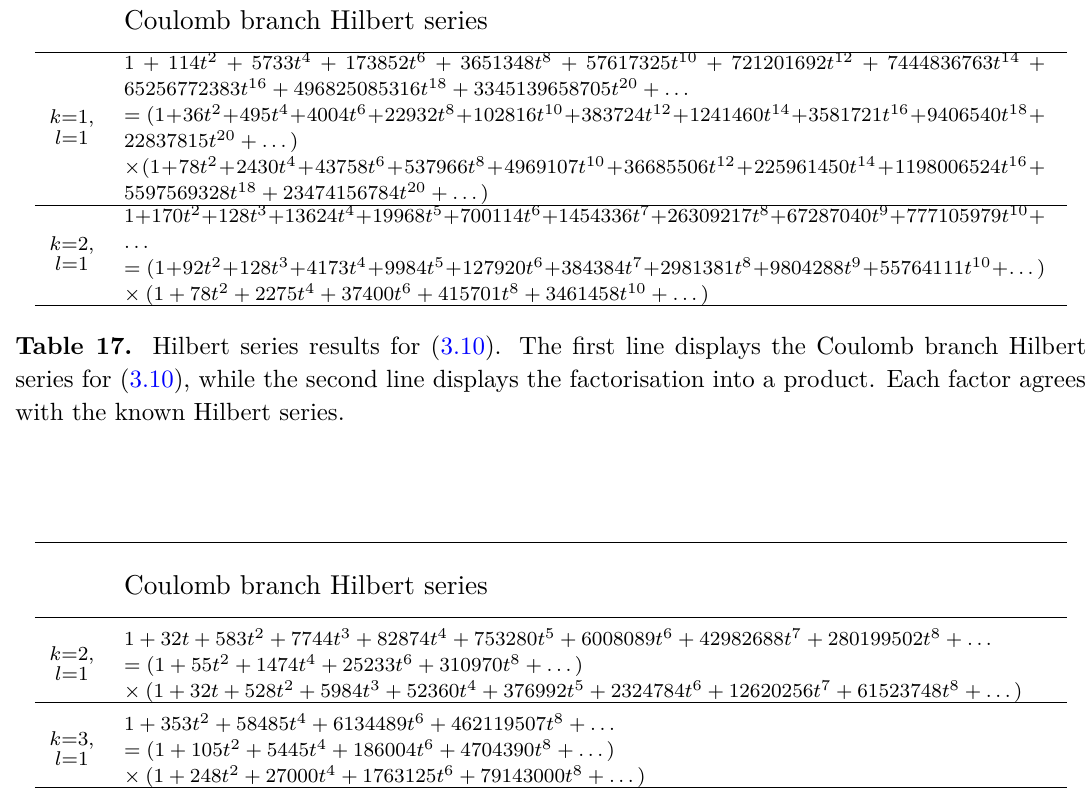
Table 18. Hilbert series results for (3.11). The first line displays the Coulomb branch Hilbert series for (3.11), while the second line displays the factorisation into a product. Each factor agrees with the known Hilbert series.